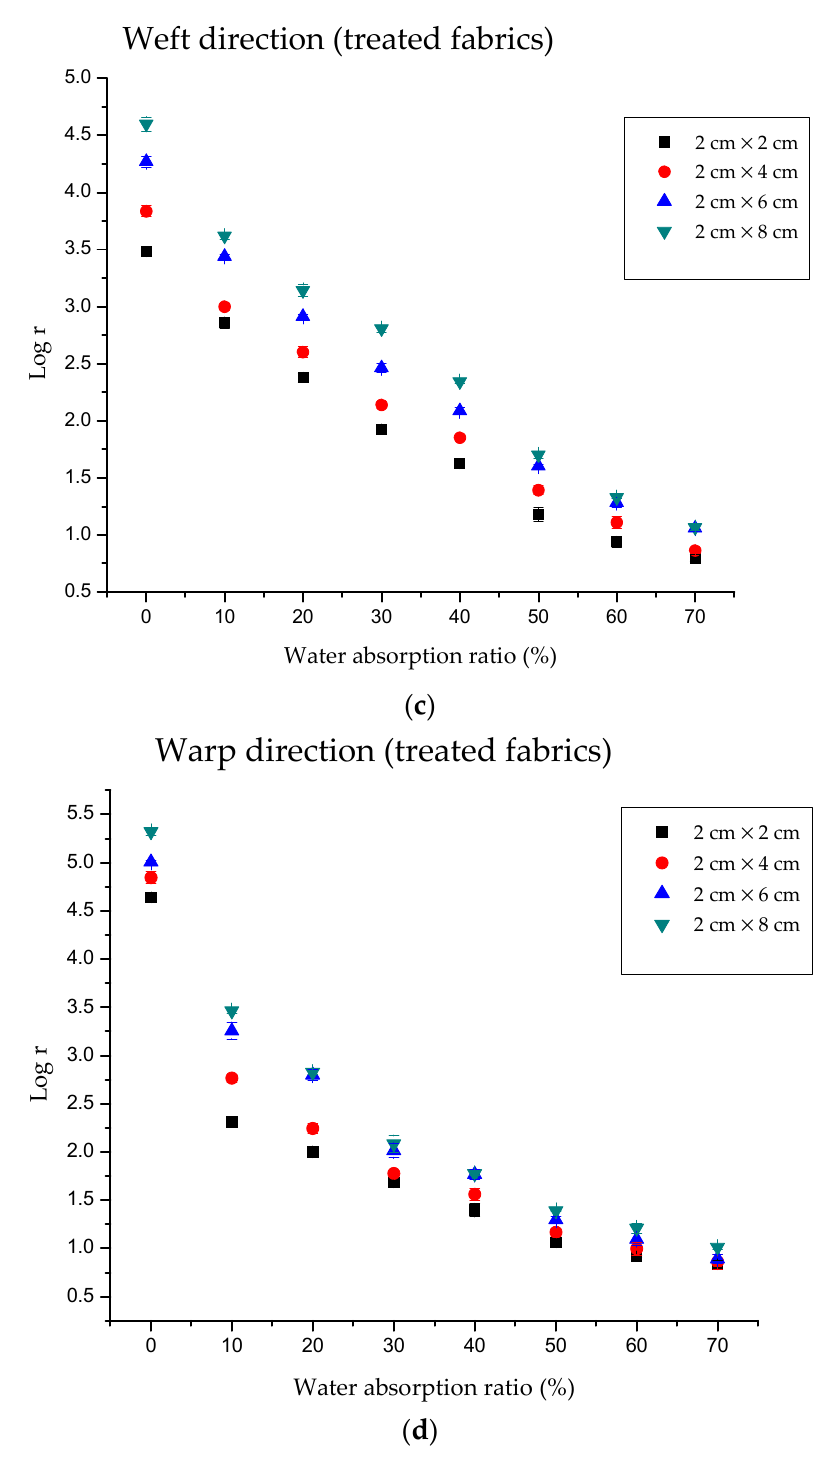
Figure 4. The electrical resistance of knitted fabric as a function of water absorption ratio. Note: y is log r , x is water absorption (%). ( a ) The electrical resistance in the weft direction for untreated fabrics; the maximum value of water absorption ratio is 40%, and the maximum of log r is about 1.5. ( b ) The electrical resistance in the warp direction for untreated fabrics; the minimum value of water absorption ratio is 40%, and the maximum of log r is about 1.8. ( c ) The electrical resistance in the weft direction for treated fabrics; the maximum value of water absorption ratio is 70%, and the maximum of log r is about 0.8. ( d ) The electrical resistance in the warp direction for treated fabrics; the maximum value of water absorption ratio is 70%, and the maximum of log r is about 0.84.